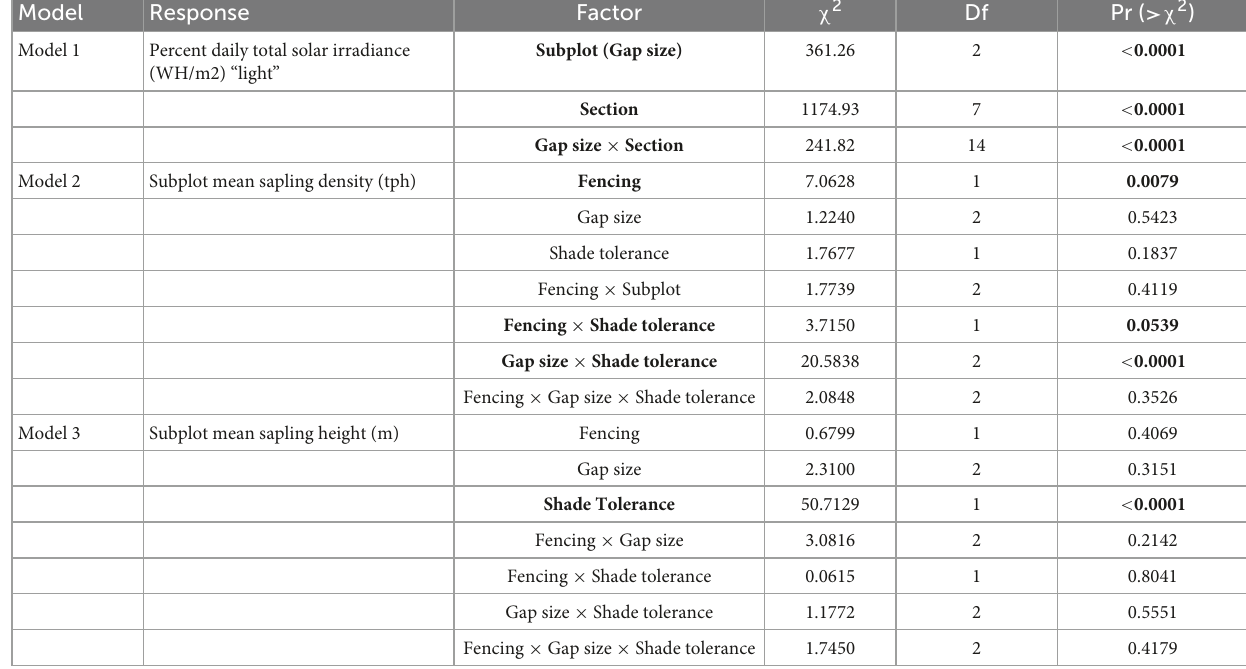
TABLE 5 Analysis of deviance tables (Type II Wald χ 2 -tests) for Models 1–3.